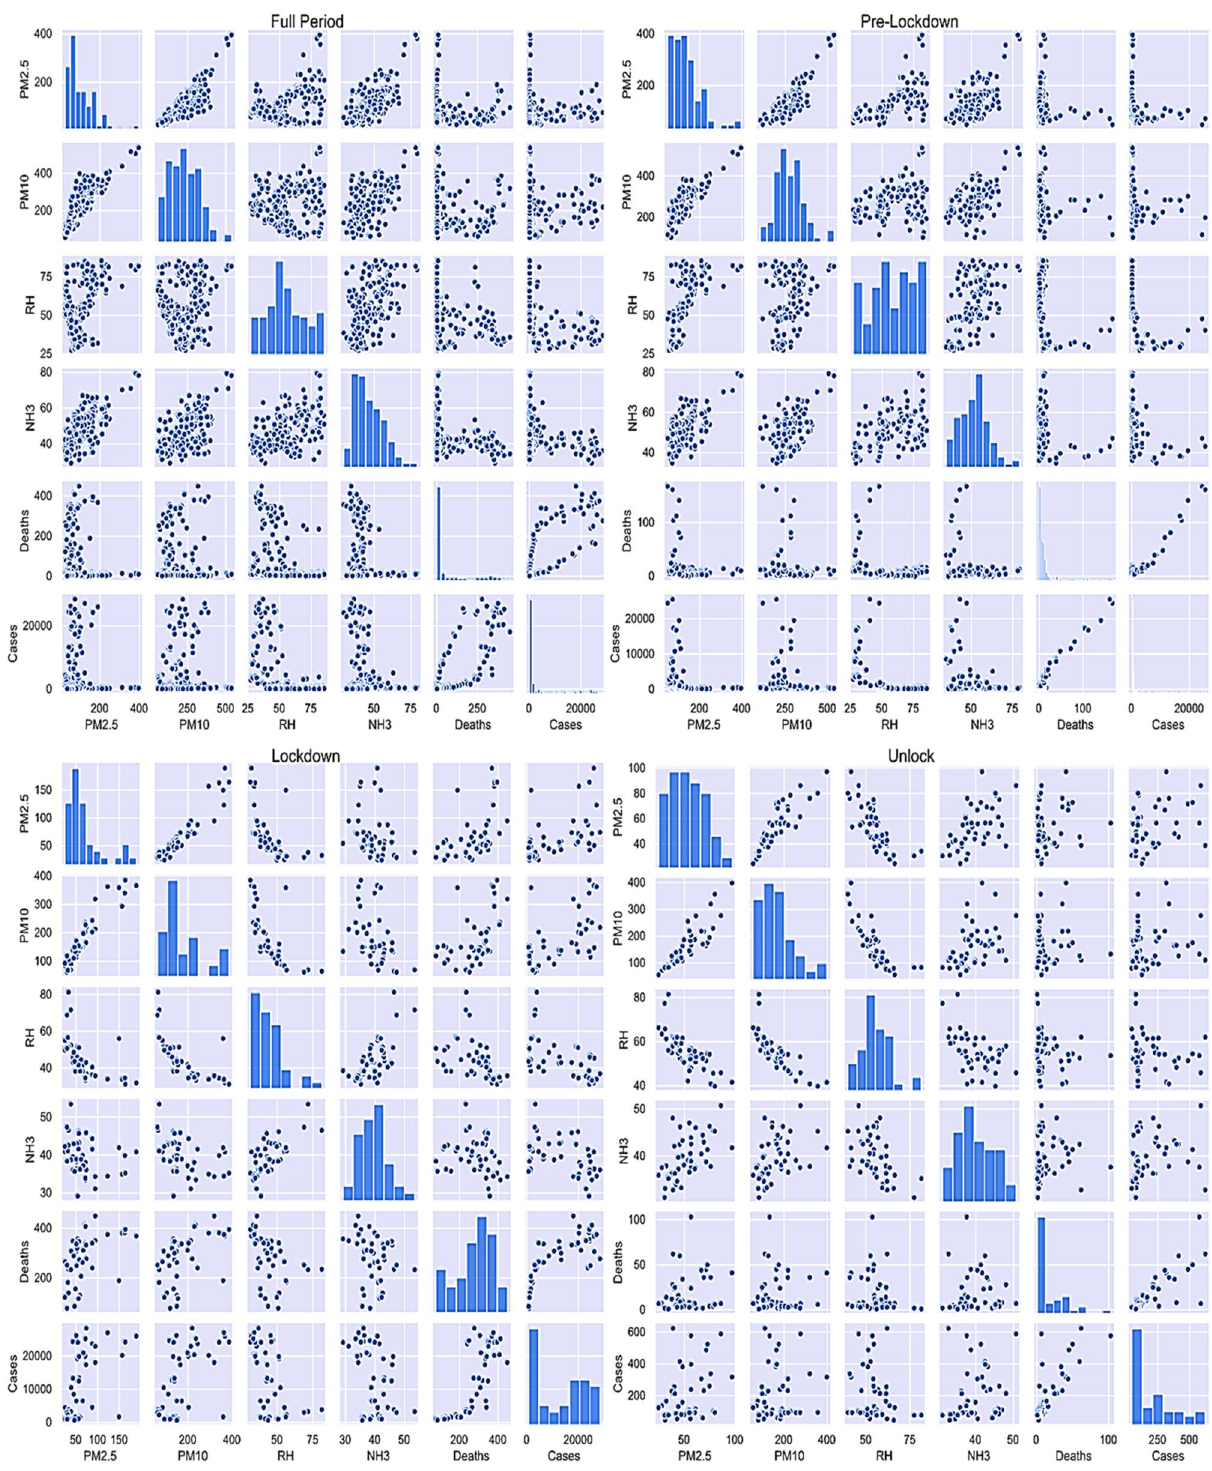
Figure 5. Pairwise relationship of different variables including environmental risk factors and COVID-19 severity for entire period, pre-lockdown period, lockdown period, and unlock